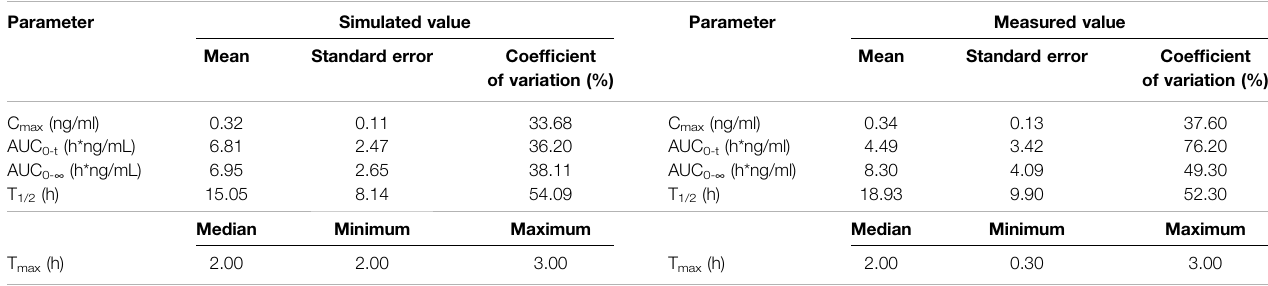
TABLE 5 | Comparison of measured PK values following intranasal administration of 0.12 mg varenicline in Americans and simulated PK values in 300 American virtual subjects. Parameter